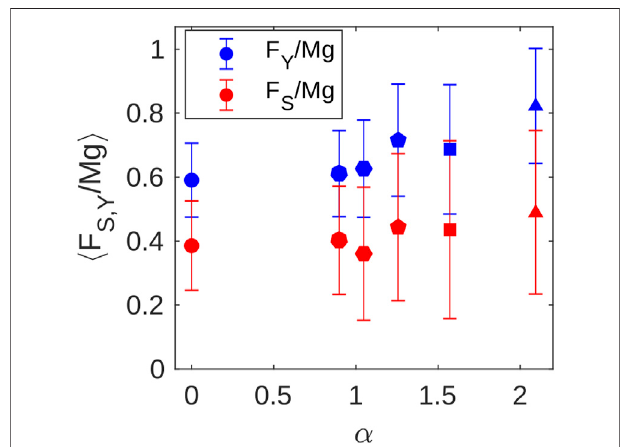
FIGURE 7 | Average force at yielding 〈 F Y / Mg 〉 (blue) and at the end of slip events 〈 F S / Mg 〉 (red). Error bars represent the standard deviation. The standard error of the average is smaller than the marker